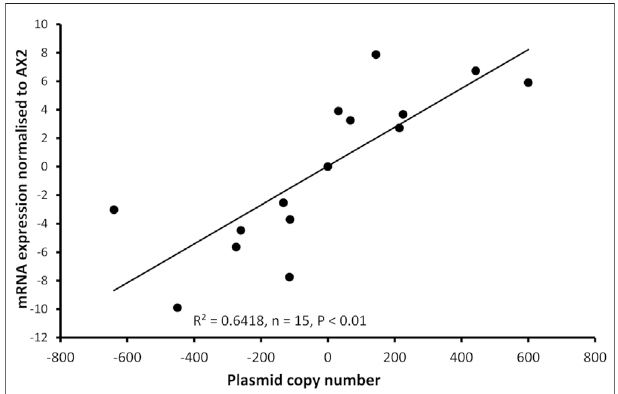
FIGURE 2 | Plasmid copy number of mucolipin strains was correlated with mRNA expression levels in the transformants. Semiquantitative RT-PCR was performed to determine mRNA expression levels in each strain. Copy numbers of overexpressing strains were determined by quantitative Southernblotting,and copynumbersofantisensestrainsweredetermined by quantitative real time PCR. Expression levels were normalised against the fi lamin mRNA to adjust for loading and then measured relative to AX2 expression.Expressioncorrelateswithplasmidcopynumbershowingthatthe antisense RNA construct decreases mcln expression and the overexpression increases it. The correlation was highly signi fi cant, p = 2.36 × 10 − 5 (Pearson product-moment correlation coef fi cient, ρ ) and similar results were also obtained using non-parametric methods (Spearman ’ s rank p = 1.195 × 10 − 5 and Kendall ’ s rank p = 9.995 × 10 − 5 ). Each point represents mean data for a single strain for three experiments. Negative values refer to copy numbers of antisense constructs and positive values to copy numbers of overexpression constructs, AX2 has a copy number of 0 as contains neither construct.